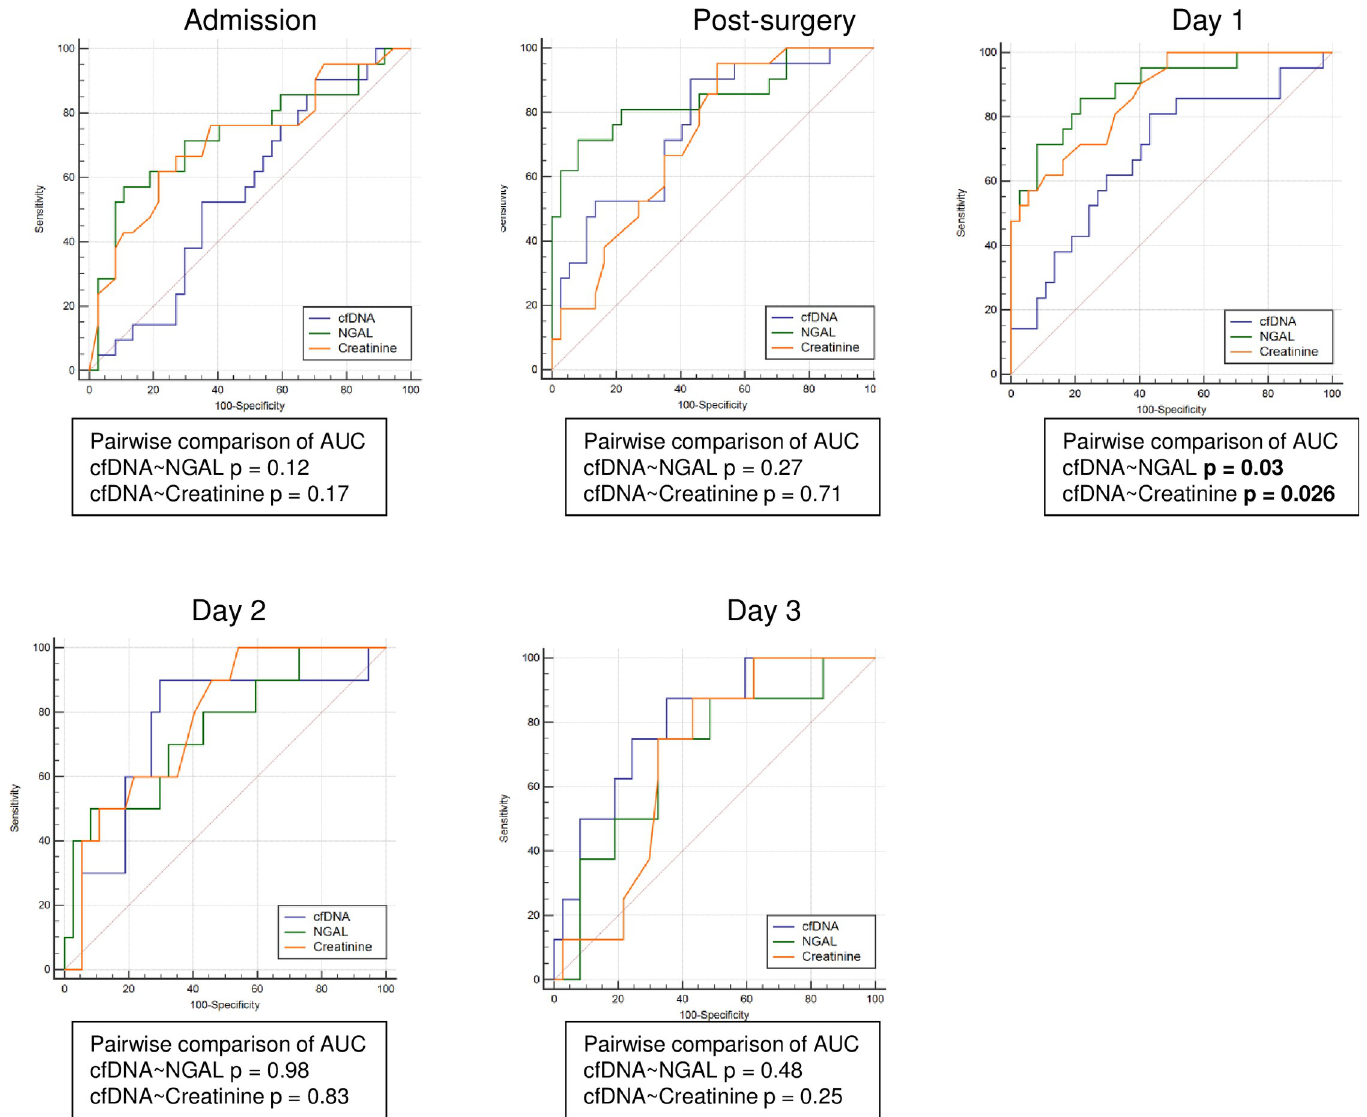
Fig 2. ROC curves. ROC curves at admission, post-surgery, day 1, day 2 and day 3 for AKI prediction.